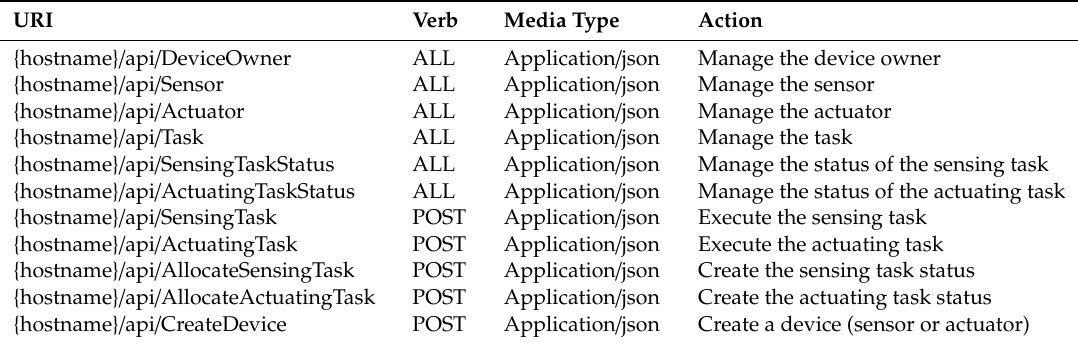
Table 1. Sample RESTful API endpoints in the business